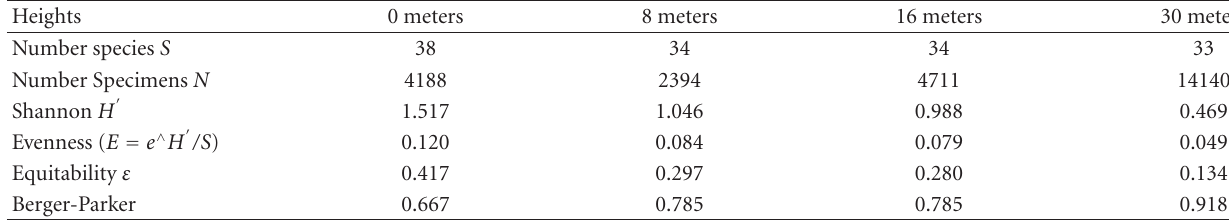
Table 4: Diversity indices for the di ff erent heights in the forest.